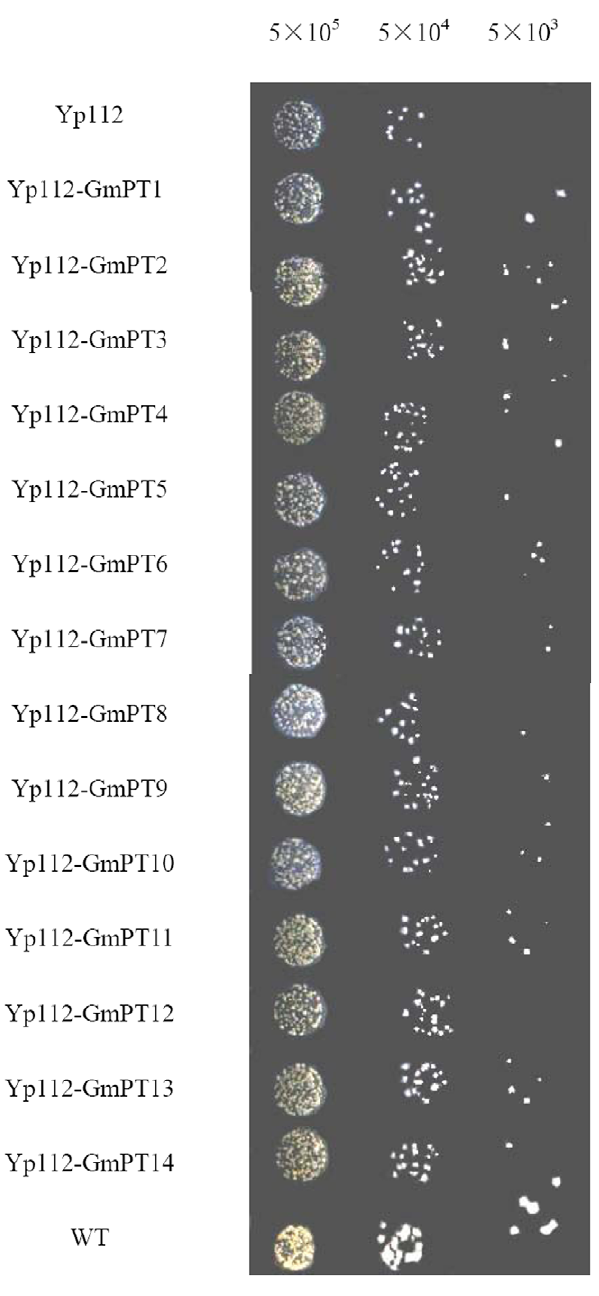
Figure 1. Phylogenetic tree of soybean, Arabidopsis, rice and Medicago plant Pi transporter proteins in Pht1 family. Transporters and corresponding plant species are as follows: rice ( Oryza sativa ), OsPT1 through OsPT13 [16]; Arabidopsis ( Arabidopsis thaliana ), AtPht1;1 through AtPht1;9 [14]; Medicago ( Medicago truncatula ) MtPT1 through MtPT6 [68] and other four PT proteins obtained in Phytozome (http://www.phytozome. net/medicago), soybean ( Glycine Max ), GmPT1 through GmPT14 (this work).